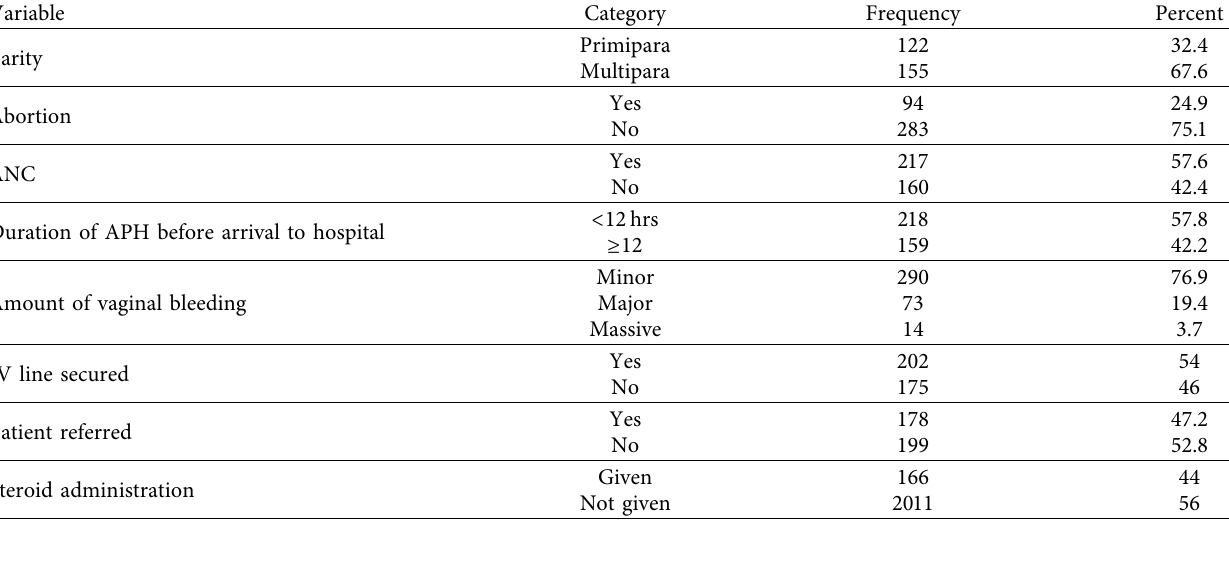
Table 3: Maternal condition on admission.